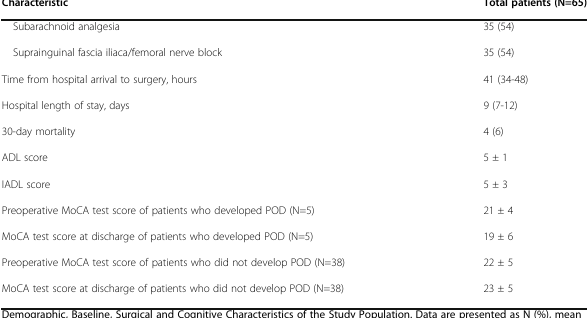
Table 1 (abstract A56). See text for description (Continued)